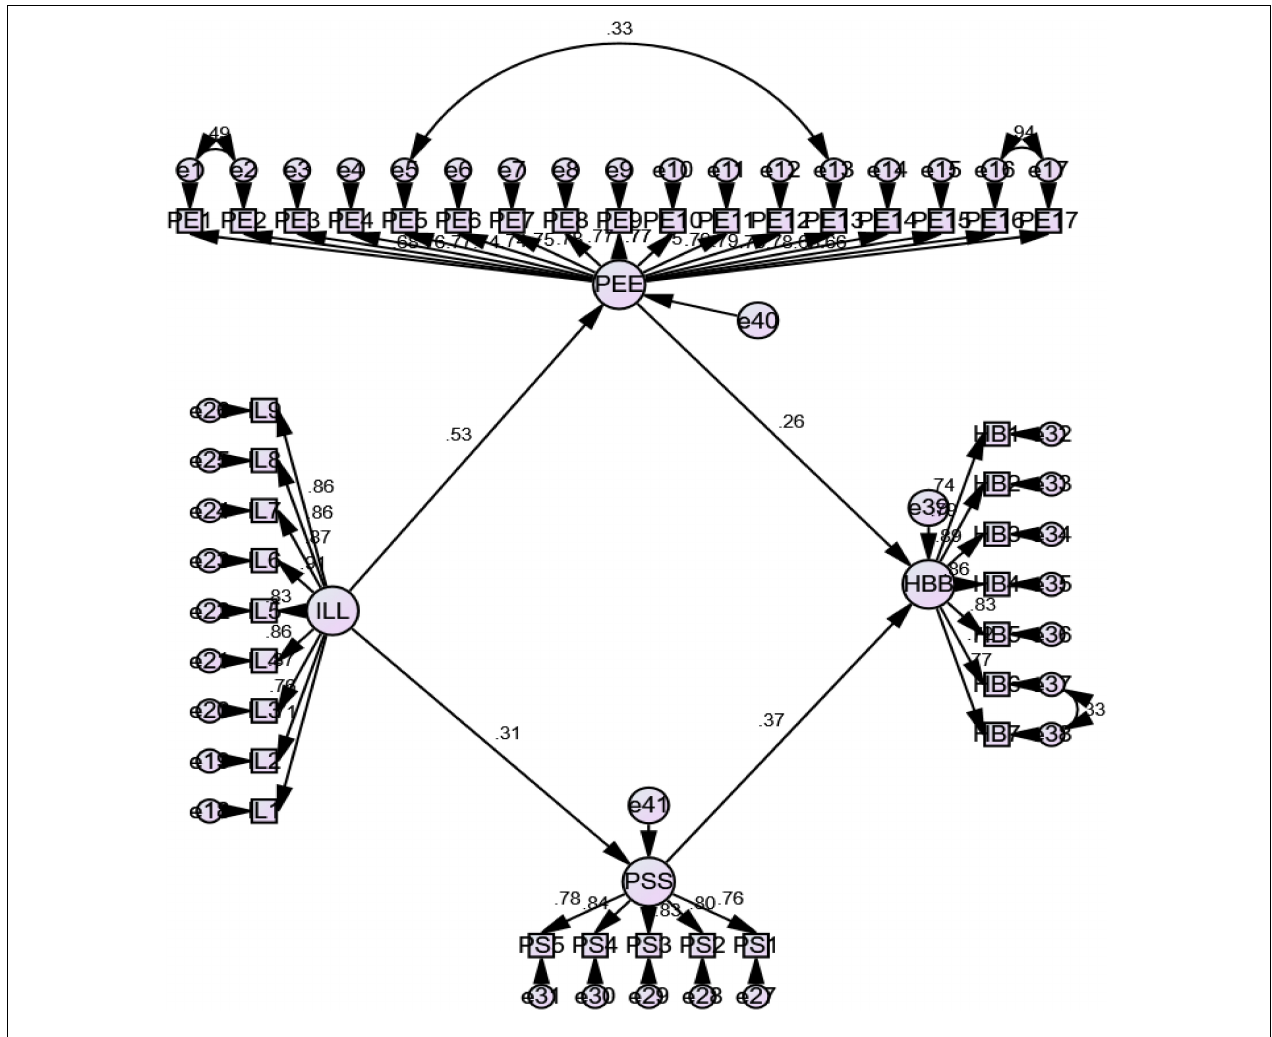
FIGURE 2 | Structural model output. TABLE 5 | Indirect